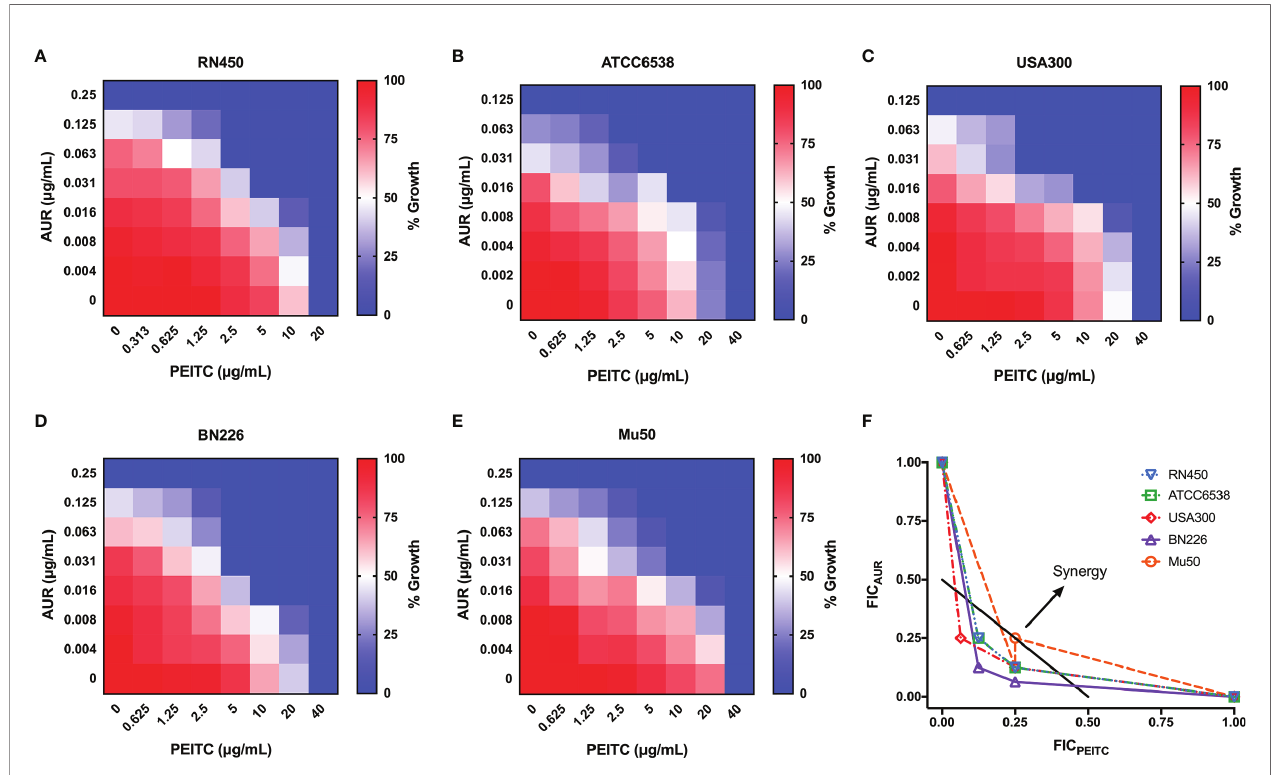
FIGURE 2 | Synergistic effect between AUR and PEITC against S. aureus strains. Representative heat plots of microdilution checkerboard assays for the combination of AUR and PEITC against (A) S. aureus RN450, (B) S. aureus ATCC6538, (C) MRSA USA300, (D) MRSA BN226, and (E) VRSA Mu50. (F) Isobolograms of the combination of AUR and PEITC against different S. aureus strains. The black full line indicates ideal isobole, where drugs act additively and independently. Data points below this line indicate synergism. AUR, aurano fi n; PEITC, phenethyl isothiocyanate; FICI, fractional inhibitory concentration index. Data in (A – E) represent the mean OD 600 of three biological